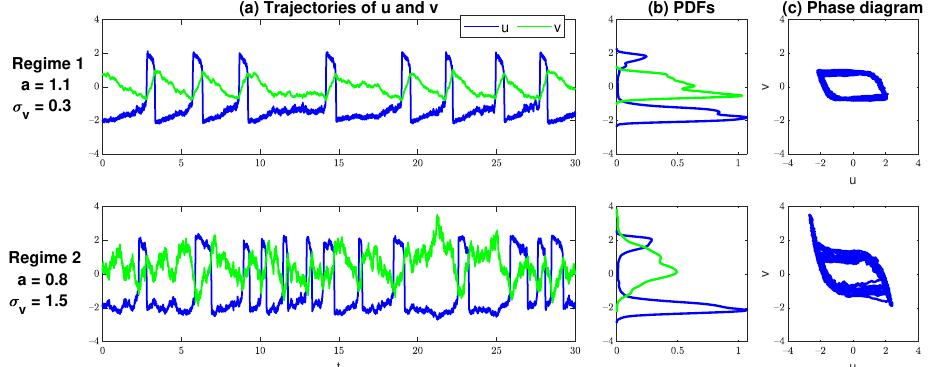
Figure 4. The two dynamical regimes of the stochastically coupled FHN model (14), where the parameters of the two regimes are listed in (15) and (16). The three columns show the model trajectories, the PDFs, and the phase diagram of both dynamical regimes.